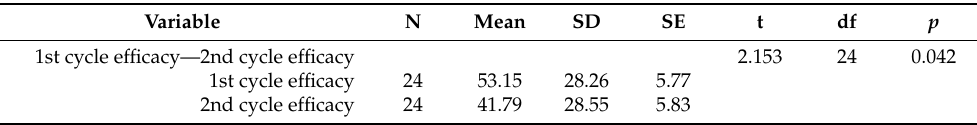
Table 7. Comparison of efficacy in treatment